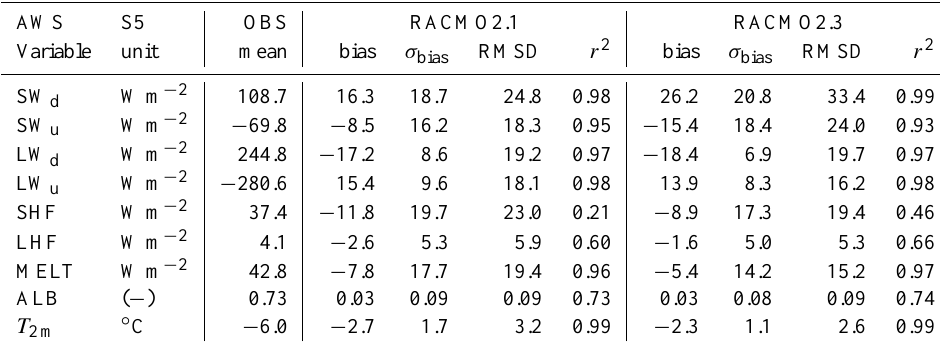
Table 1. Modelled and observed annual mean SEB components and statistics of the differences (2004–2012) at station S5 (67 ◦ 06 (cid:48) N, 50 ◦ 05 (cid:48) W, 490ma.s.l) in the ablation zone. Statistics include means of measurements collected at S5, model bias (RACMO2 – observations), standard deviation of the bias, Root Mean Square Difference (RMSD) of the bias as well as determination coefficient between RACMO2 and S5 observations. Fluxes are set positive for downward radiation.